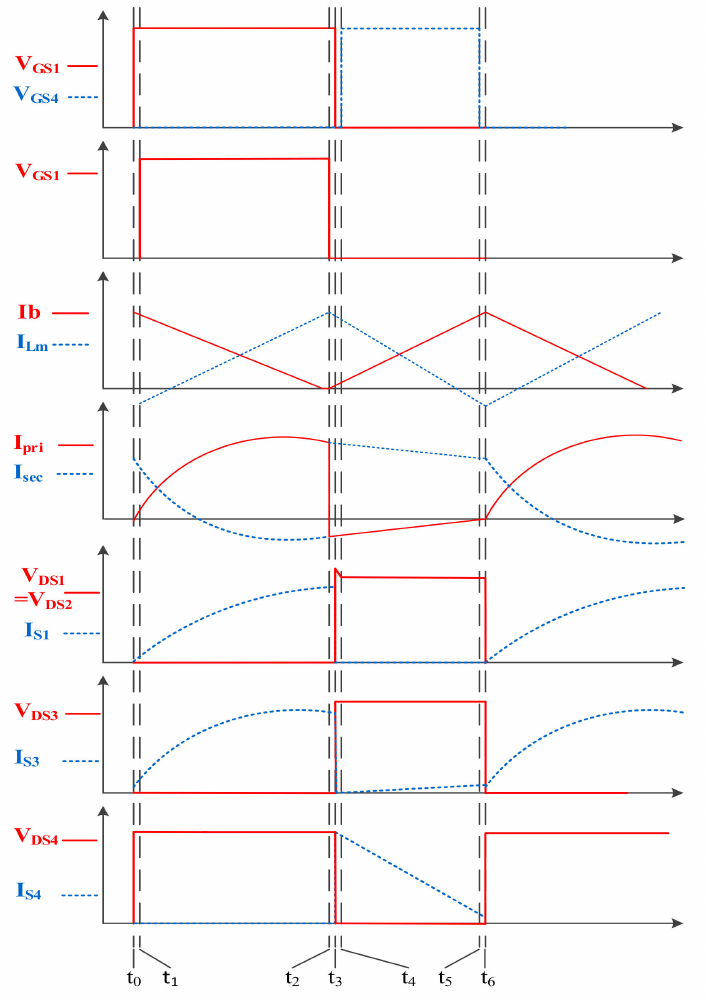
Figure 6. Key waveforms in Stage